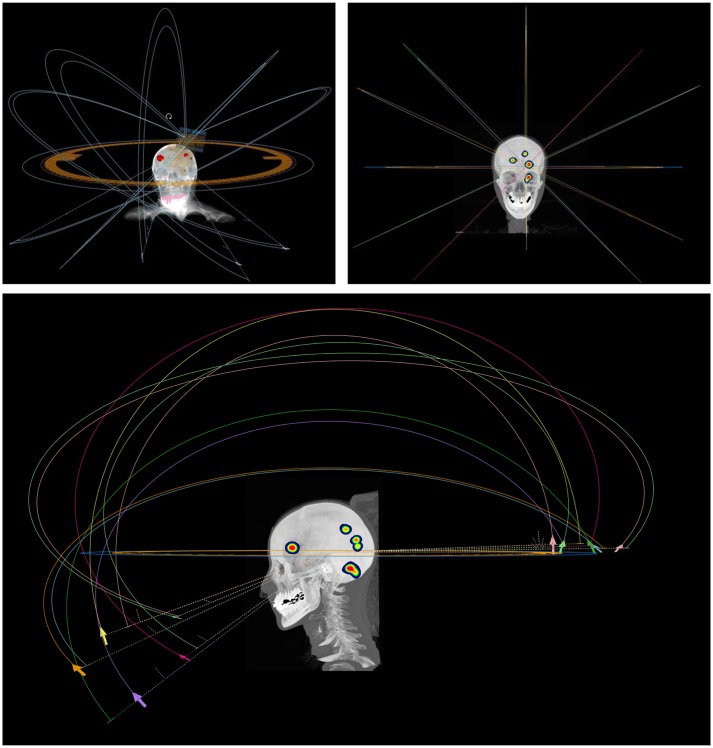
Arc arrangement for single-isocenter volumetric modulated arc therapy (SI-VMAT); treatment planning was based on the use of six non-coplanar dual arcs with fixed couch angles of 0, 25, 45, 90, 315, and 335°.